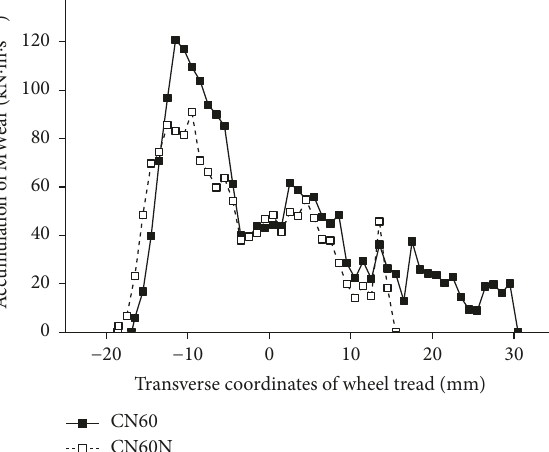
Figure 10: Influence of vertical damping of secondary suspension on the cumulative wear power dissipation of the wheel.